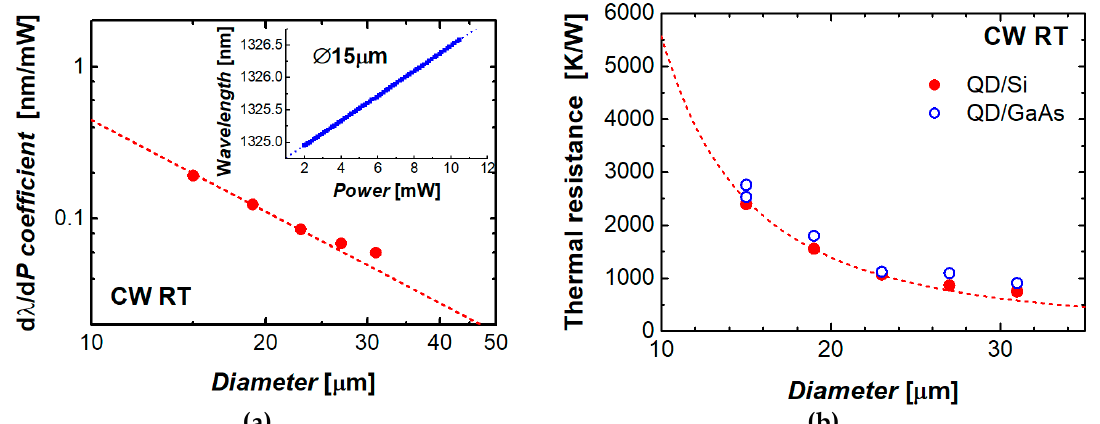
Figure 8. ( a ) Coefficient, which describes power-induced shift of the mode wavelength vs microdisk diameter. Inset: mode wavelength as function of consumed power for a 15 µ m microlaser; ( b ) thermal resistance of QD microdisk lasers: solid circles—monolithic integration with Si, open circles—microlasers on GaAs. Dashed line: 5·10 ‒ 3 (K/W)·cm 2 .